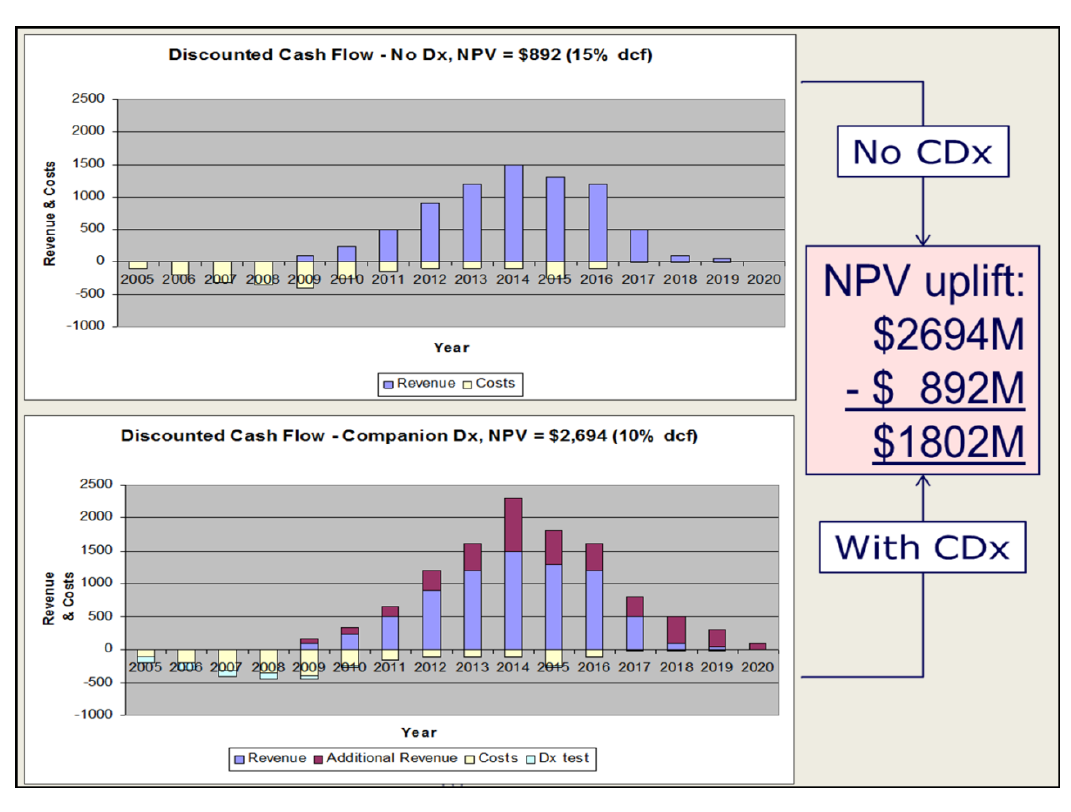
Figure 1. Adapted with permission from Blair E.D. (2008)